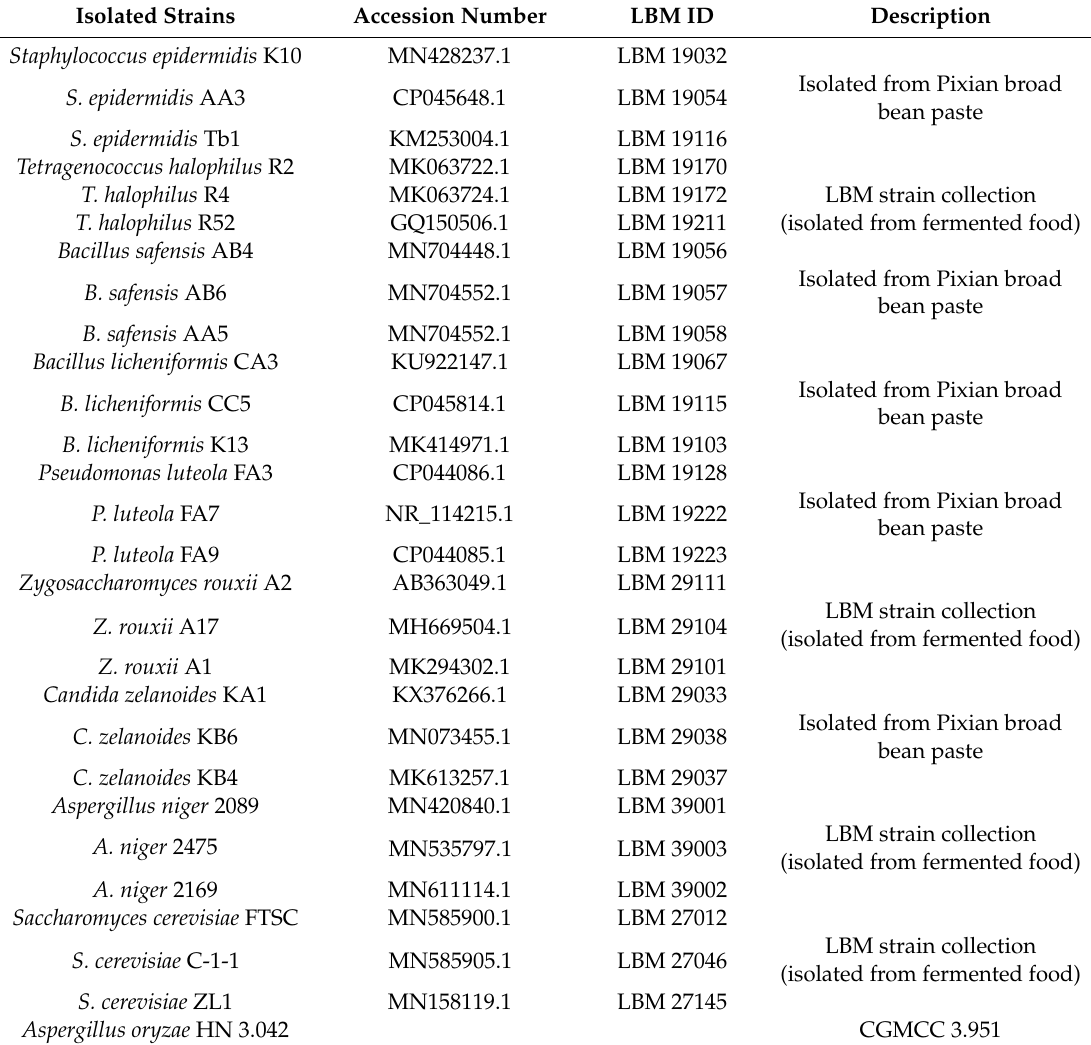
Table 1. Strains used in this